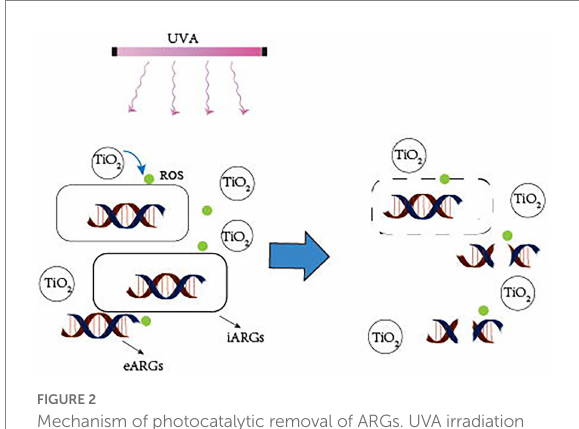
FIGURE 2 Mechanism of photocatalytic removal of ARGs. UVA irradiation causes the catalyst to create ROS, which attack the bacterial cell wall, breaking it down and converting iARGs to eARGs. Simultaneously, ROS attack eARGs, breaking the DNA strand, and inactivating